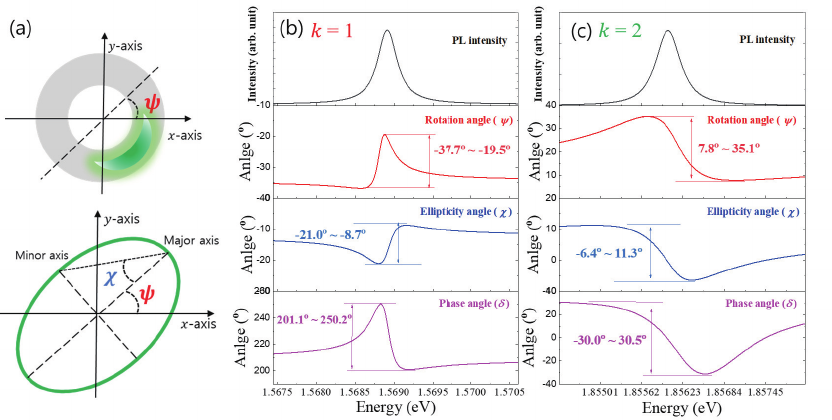
Figure 3. ( a ) A crescent − like localized wavefunction gives rise to an elliptical polarization. ( b ) Three spectra of polarization parameters ( ψ , χ , and δ ) were obtained from the PL spectrum of the k = 1 state. Likewise, three spectra of polarization parameters in the k = 2 state were plotted ( c